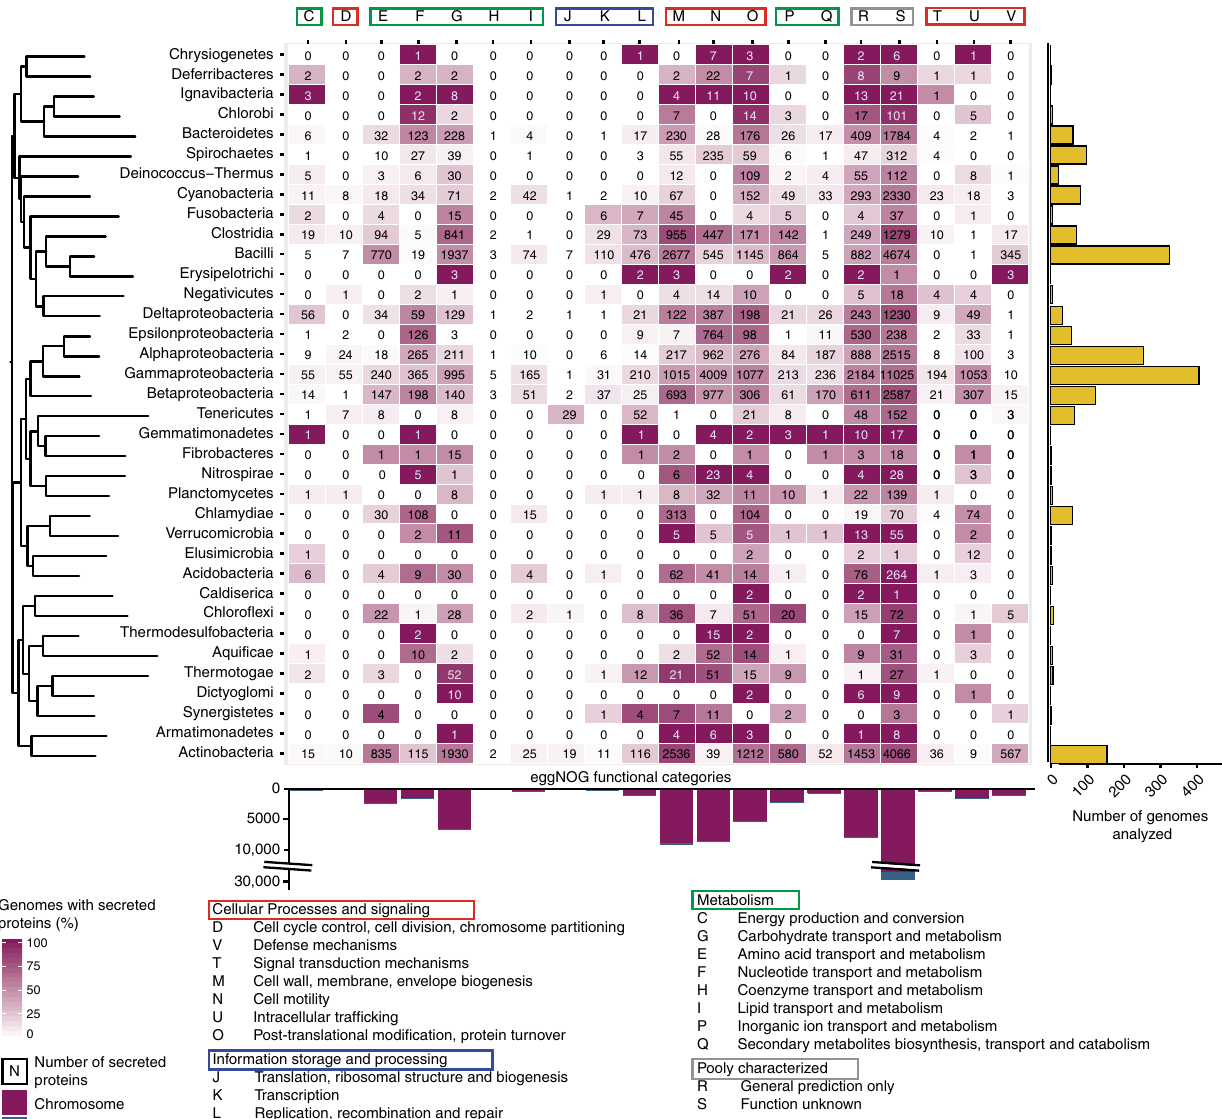
Fig. 1 Number of genes encoding extracellular proteins per large taxonomic group and in terms of COG protein function. The colors of the heatmap indicate the percentage of genomes in the clade encoding extracellular proteins associated to speci fi c functional groups. In the absence of a consensual phylogenetic tree of prokaryotes, we constructed a phylogenetic tree using the 16S rRNA phylogeny. The bar plots resume the number of genomes analysed (right) and of genes encoding extracellular proteins (bottom). Supplementary Fig. 3 shows the dotplot representing the relative frequencies of each COG category in chromosomes and